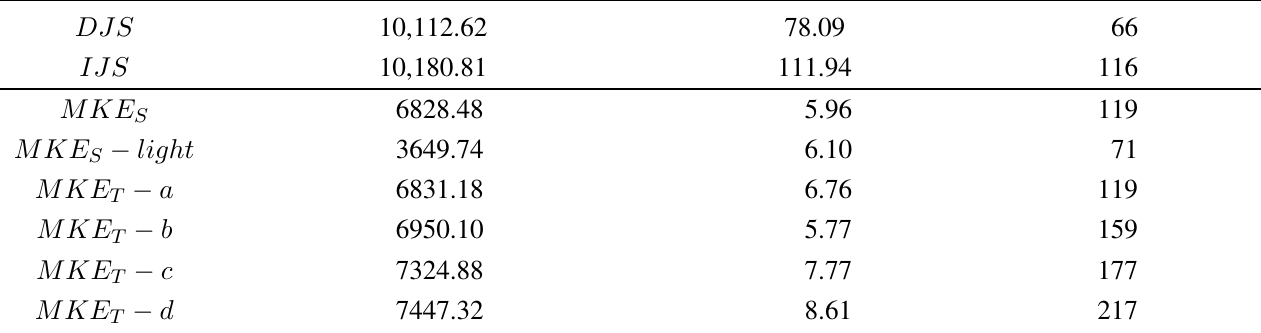
Table 3. Total execution time and total size of exchanged messages of our protocols using a 160-bit ECIES key and a 128-bit AES-CTR